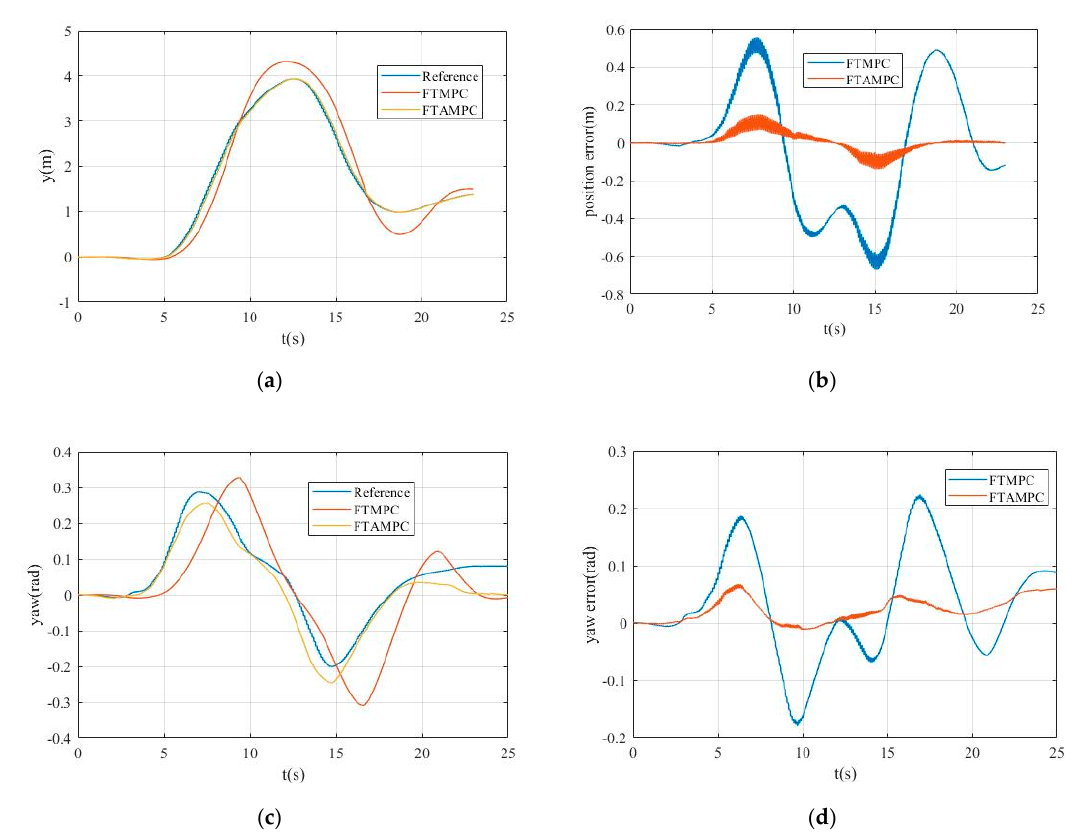
Figure 16. The path tracking control experiment results: ( a ) the lateral position changes; ( b ) the lateral position error; ( c ) the yaw angle changes; and ( d ) the yaw angle error.